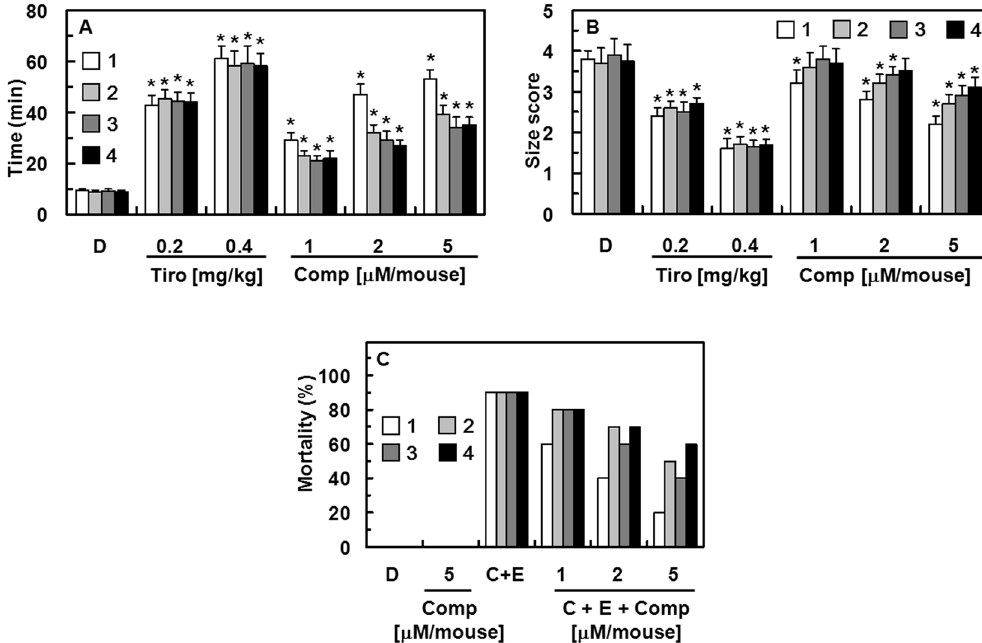
Figure 7. Effects of compounds 1–4 on arterial and pulmonary thrombosis. ( A ) Time to large thrombi formation by compounds 1–4 . Tirofiban (Tiro, 0.2 or 0.4 mg/kg) was used as a positive control. ( B ) Thrombi were scored for size 60 min after FeCl 3 -treatment as described in “Supplementary Materials and Methods.” ( C ) After each compound was injected intravenously, a mixture of collagen (C, 500 µ g/kg) and epinephrine (E, 50 µ g/kg) was injected into the tail vein of mice to induce acute thrombosis 6 h later. Afterward, mice (20 mice per group) were carefully examined for 15 min to determine whether the mouse was paralyzed, dead, or had recovered from the acute thrombosis challenge. D = 0.2% DMSO used as the vehicle control. * p < 0.05 vs. DMSO, analyzed via one-way ANOVA, followed by Tukey multiple comparison